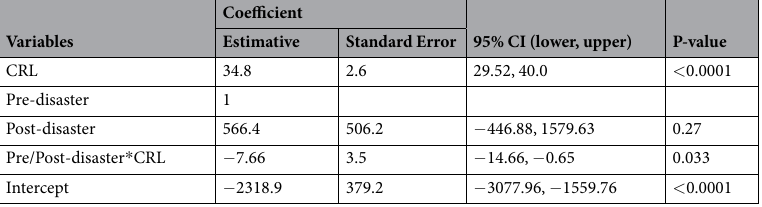
Table 5. Multiple linear regression for head size in Japanese monkey fetuses in Fukushima (n = 62). R 2 = 0.86; adjusted R 2 =